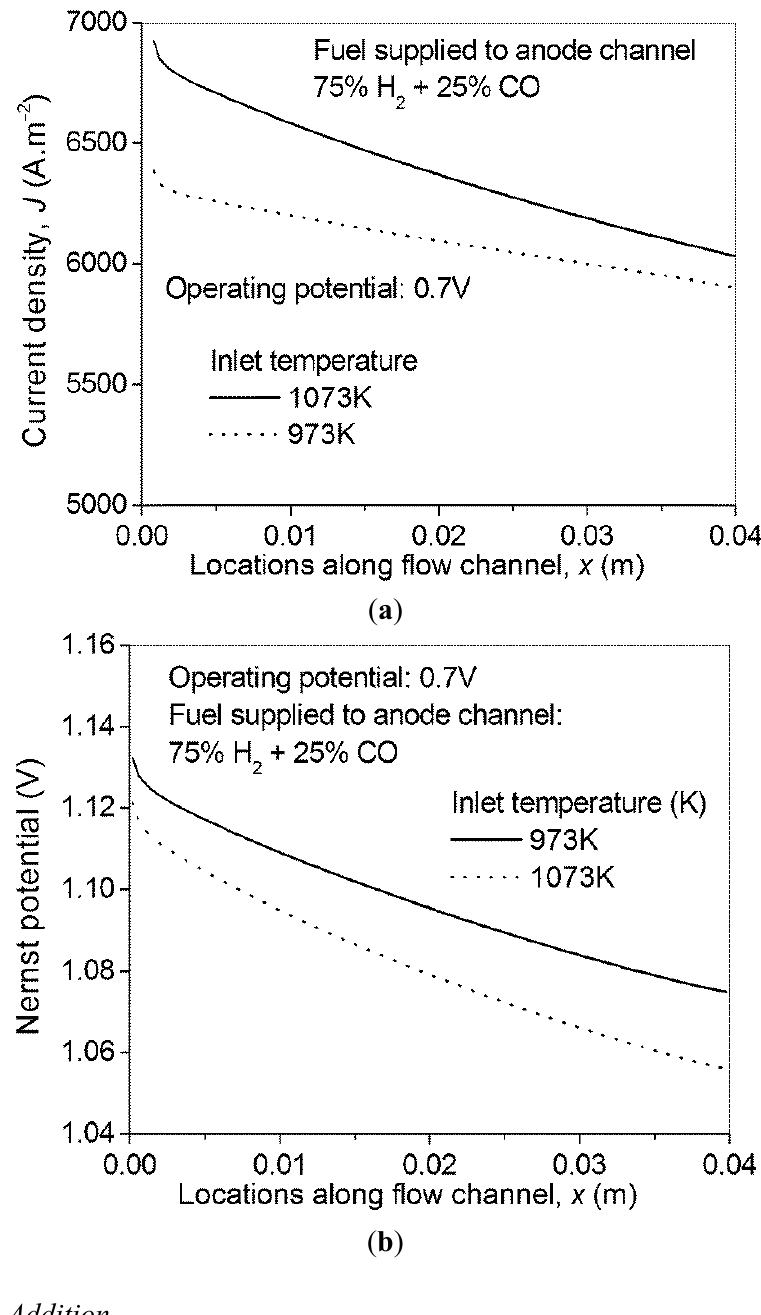
Figure 6. Effect of inlet temperature on H-SOFC performance—( a ) local current density; and ( b ) local Nernst